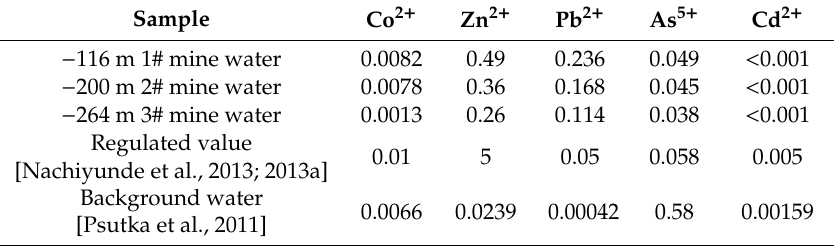
Table 2. Heavy metal ion concentrations in the underground mine water (mg /